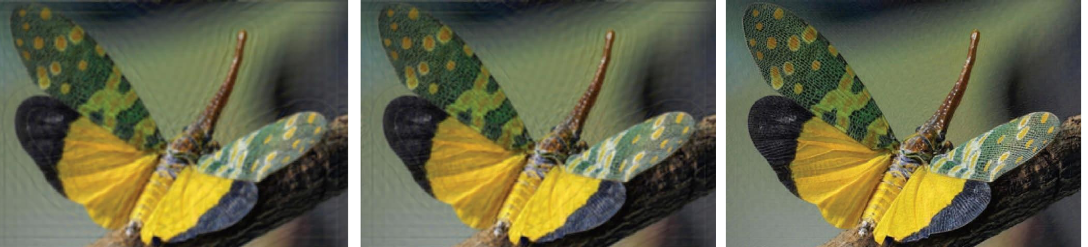
Figure 4: Rebuilt images degraded by blurred matrices M